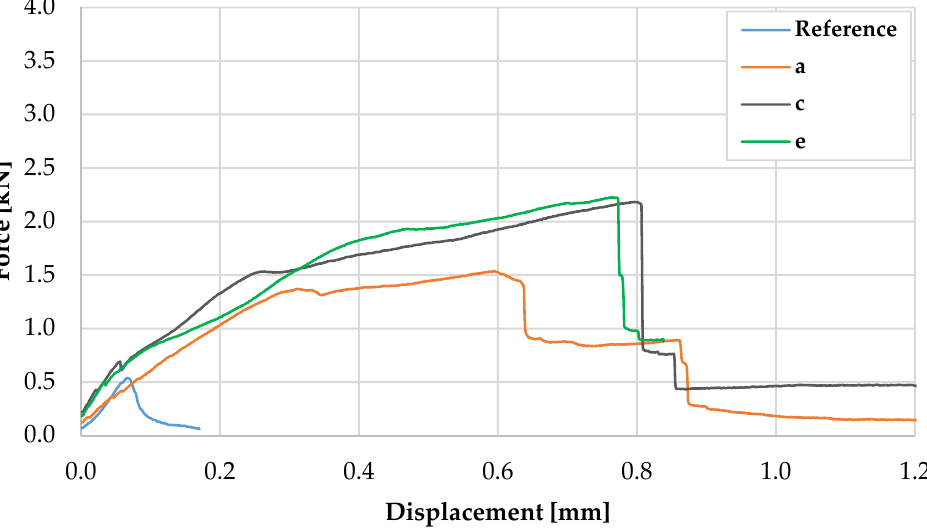
Figure 15. Representative force–displacement curves for specimen with a cross-section of 25 mm × 20 mm.